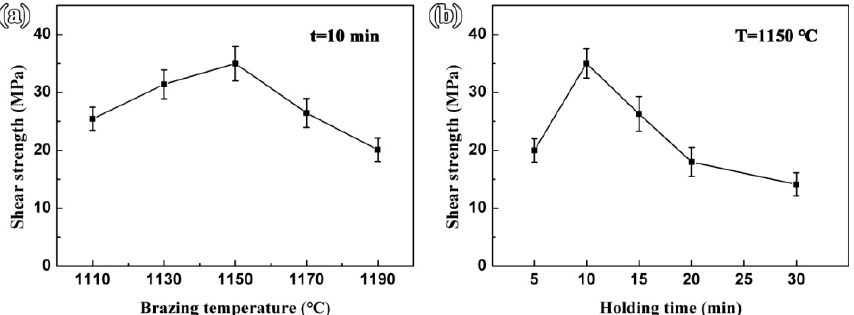
Figure 7. Effect of brazing parameters on shear strength of titanium/Au/ZrO 2 joint. ( a ) Brazing Figure 7. E ff ect of brazing parameters on shear strength of titanium / Au / ZrO 2 joint. ( a ) Brazing temperature and ( b ) holding time. temperature and ( b ) holding